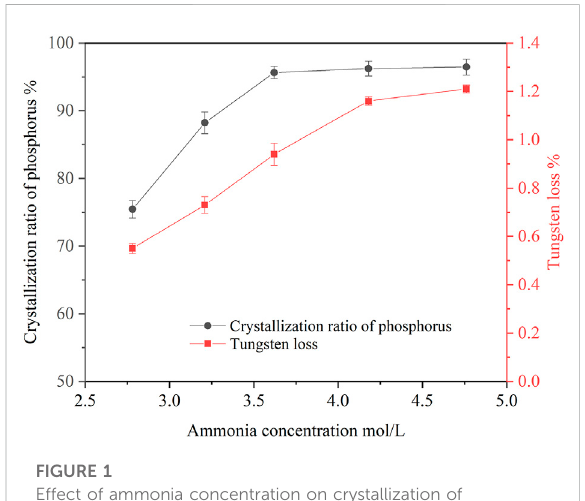
FIGURE 2 Effect of temperature on crystallization of